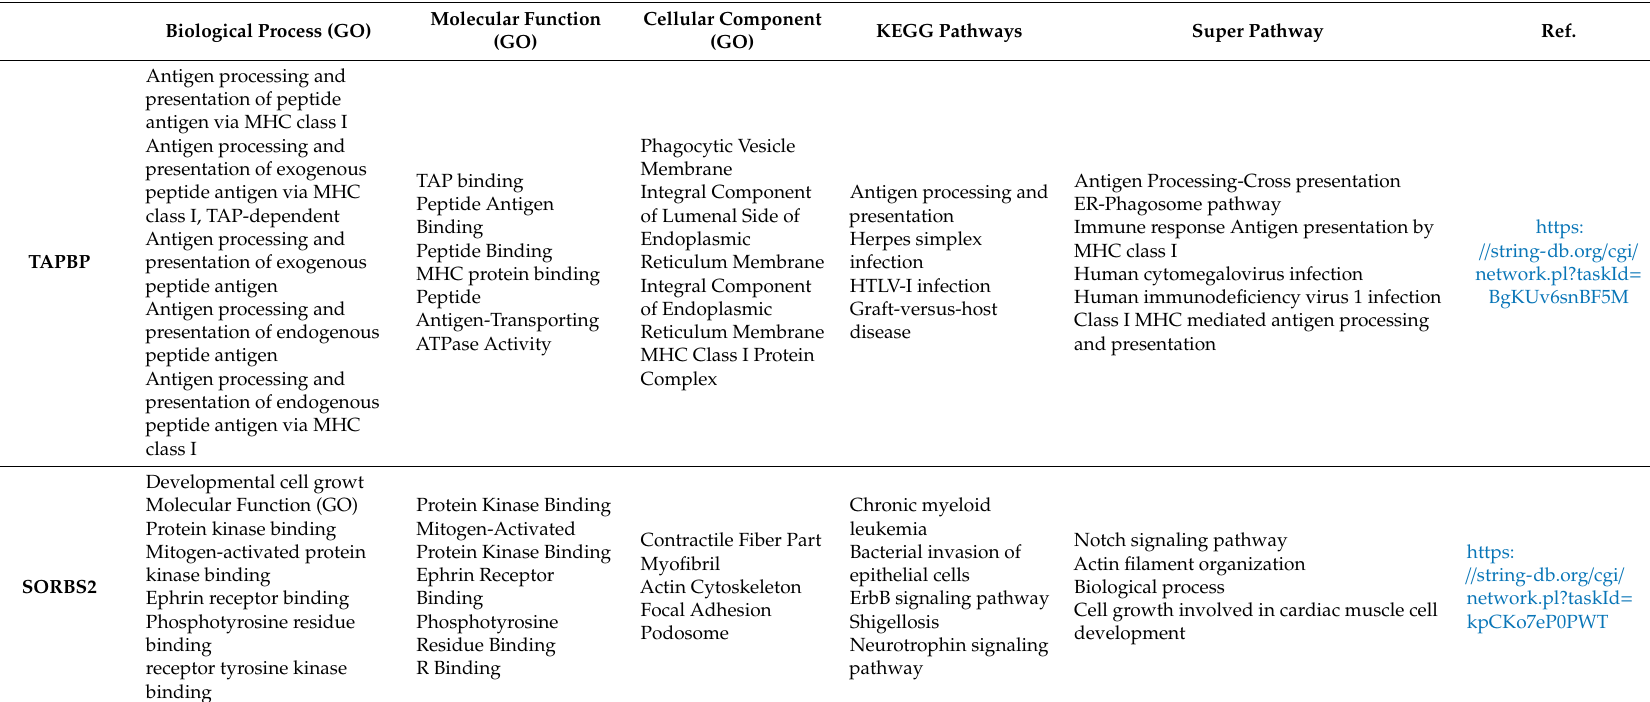
Table 2. A summary of biological pathways related to the TAPBP, BDNF , and SORBS